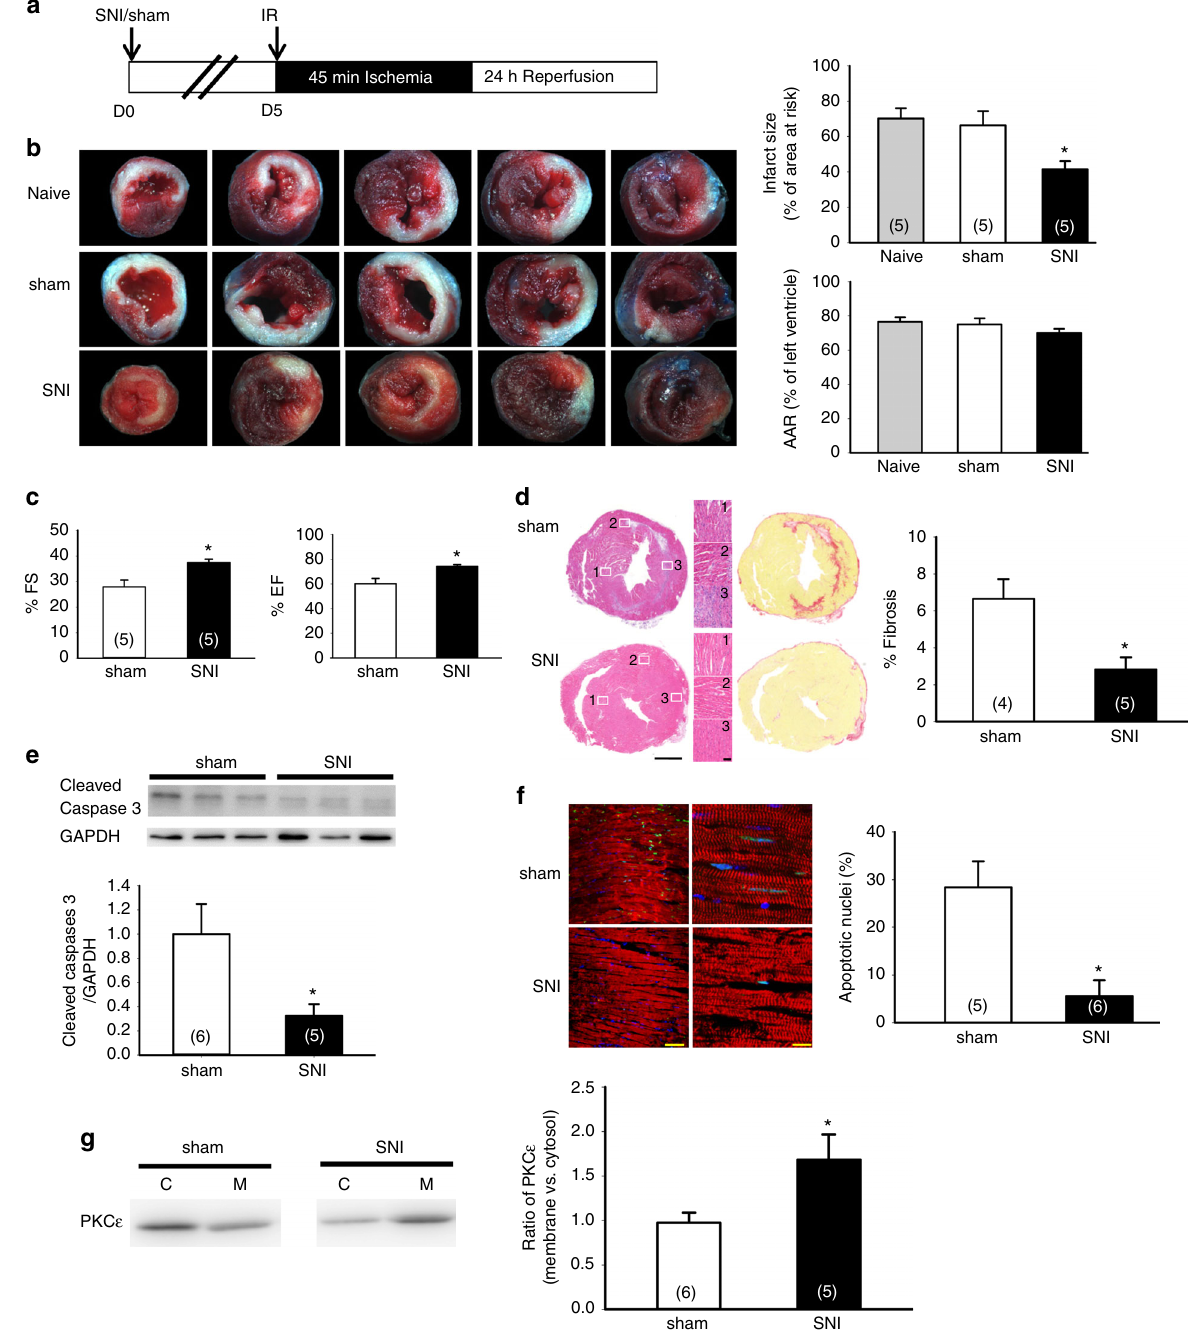
Fig. 1 SNI-induced chronic neuropathic pain provides cardioprotection against IR injury. a Schematic of experimental design showing the timeline for SNI surgery (D0) and myocardial IR surgery (D5). b Left panel , representative images of TTC staining showing area of infarct region ( pale color ) and AAR in heart cross-sections from different treatments. Evans blue dye was injected retrogradely from aorta into coronary circulation to delineate the remote area. The infarcted size was determined by TTC (1%) staining. Right panel , quanti fi cation results of infarct size and AAR. * p < 0.05 SNI vs. sham and naïve groups. c Percentage of fractional shortening (% FS) and ejection fraction (% EF) from sham and SNI groups by echocardiography. * p < 0.05 SNI vs. sham. d Representative images of H&E staining ( left panel ) and picrosirius red staining ( right panel ) of cardiac sections 4 weeks after IR injury from sham and SNI groups. Areas marked by white rectangles were magni fi ed and shown in the middle panel . Scale bar = 1 mm and 50 μ m. Bar graph, quanti fi cation results of fi brosis in left ventricles. * p < 0.05 SNI vs. sham. e Upper panel , immunoblotting of cleaved caspase 3 from left ventricle lysate 24 h after IR in SNI or sham groups. Lower panel , quanti fi cation results of cleaved caspase 3 immunoblotting. * p < 0.05 SNI vs. sham. f Representative images of TUNEL stain in cardiac sections ( red : α -actinin, green : TUNEL signal, blue : DAPI). Quanti fi cation was conducted by entire slices scanning and TUNEL-positive signals (green fl uorescence) were normalized to total nuclei (DAPI, blue fl uorescence). Apoptotic activity was assayed by TUNEL stain 24 h after IR injury in SNI or sham groups. * p < 0.05 SNI vs. sham group. Scale bar = 50 μ m ( left panel ) and 10 μ m ( right panel ). g Representative immunoblotting and quanti fi cation of cytosolic and membrane fraction of PKC ε in left ventricular lysate. * p < 0.05 SNI vs. sham group. Error bars indicate SEM. Sample numbers are indicated within parentheses in all fi gures. Statistical signi fi cance was determined by one-way ANOVA ( b ) or Student ’ s t- test ( c – g ) NATURE COMMUNICATIONS | 8: 826 | DOI: 10.1038/s41467-017-00891-z |